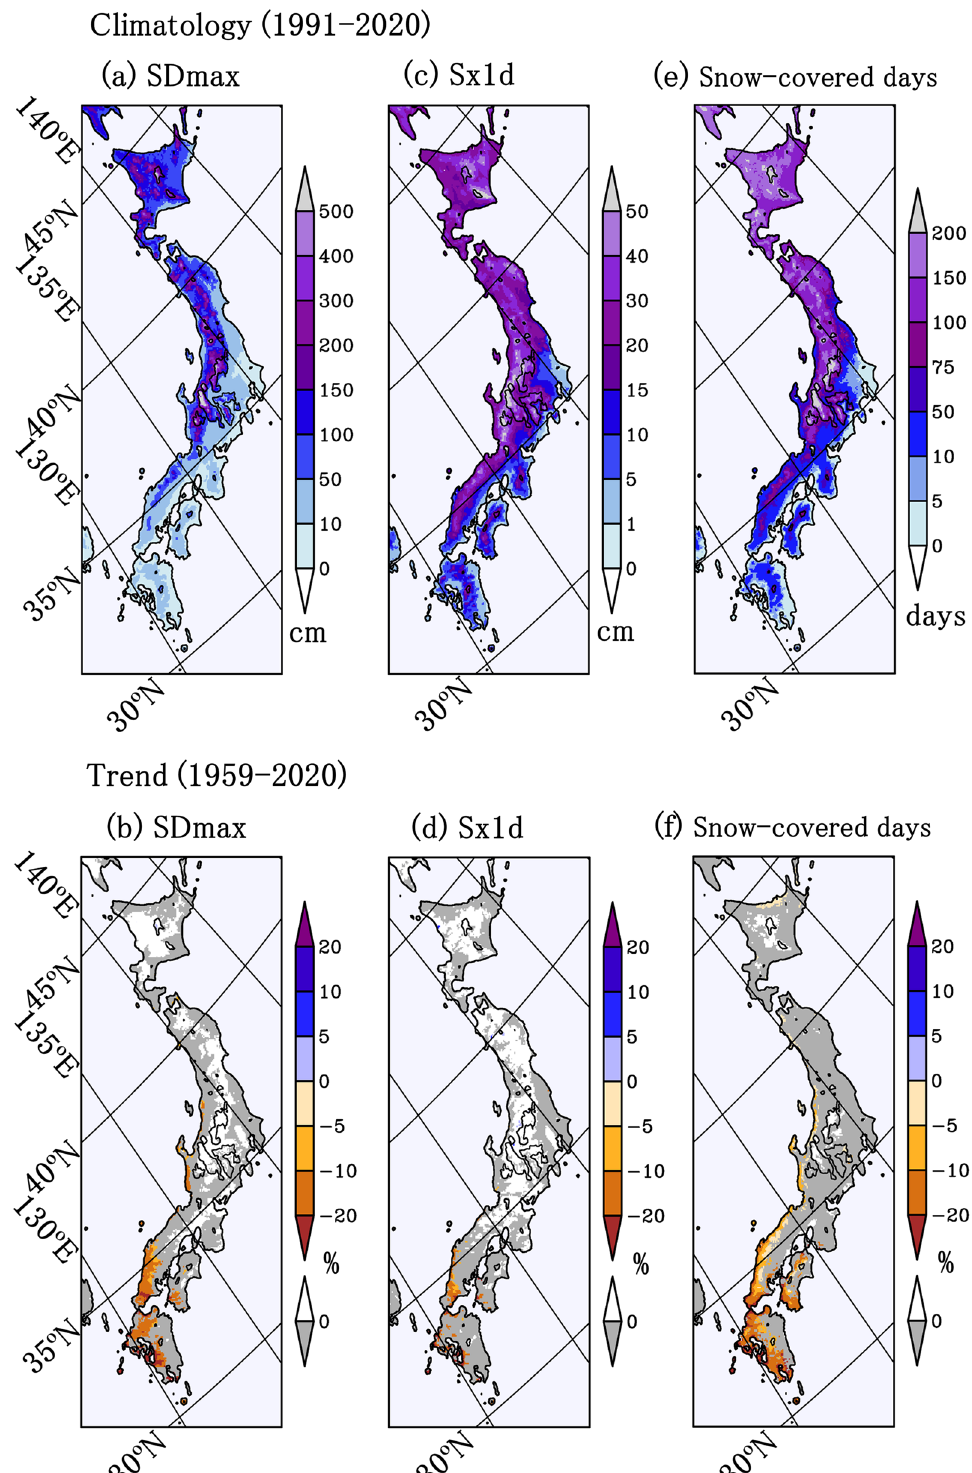
Fig. 7 Climatology in 1991–2020 and linear trends from 1959 to 2020. a , c , d Climatology of SDmax, Sx1d, and snow‑covered days, respectively; b , d , f linear trends of SDmax, Sx1d, and snow‑covered days, respectively. Gray and white shadings represent decreasing and increasing trends, respectively, which are statistically insignificant with a 95% confidence